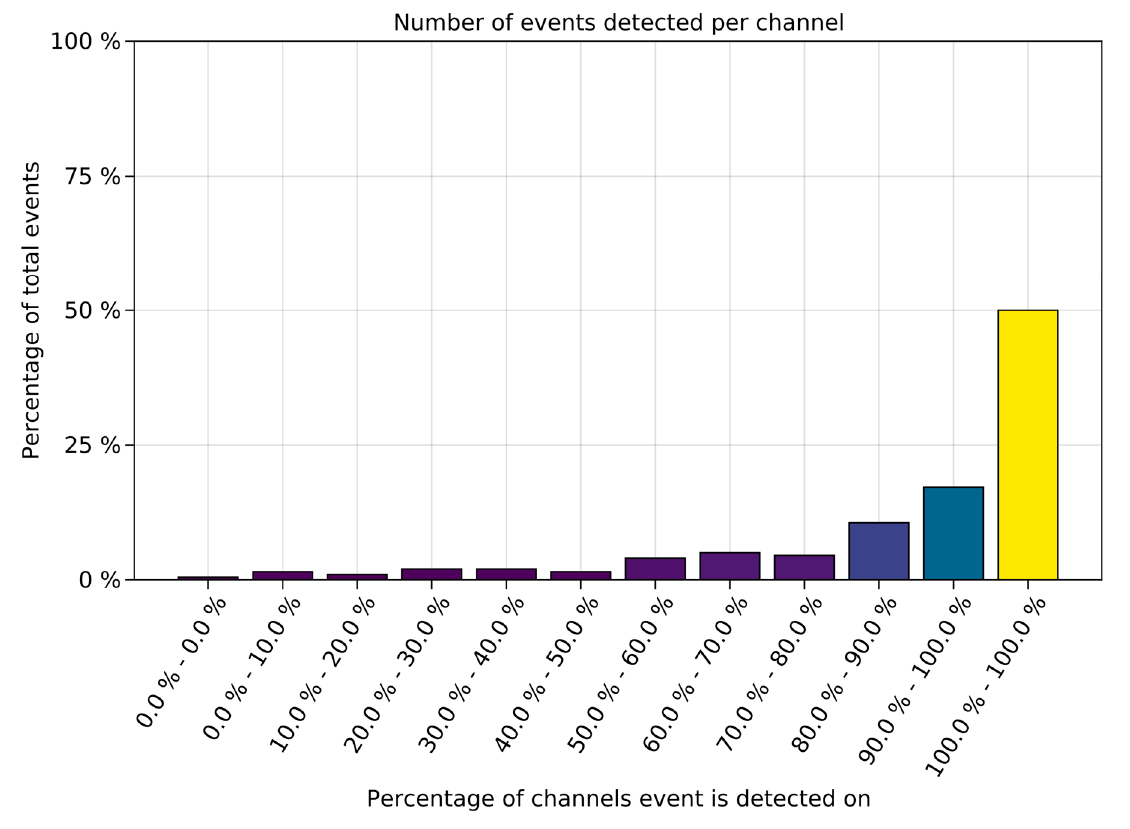
Figure 4. Barplot of seizure prediction as a percentage of total channels in the recording.